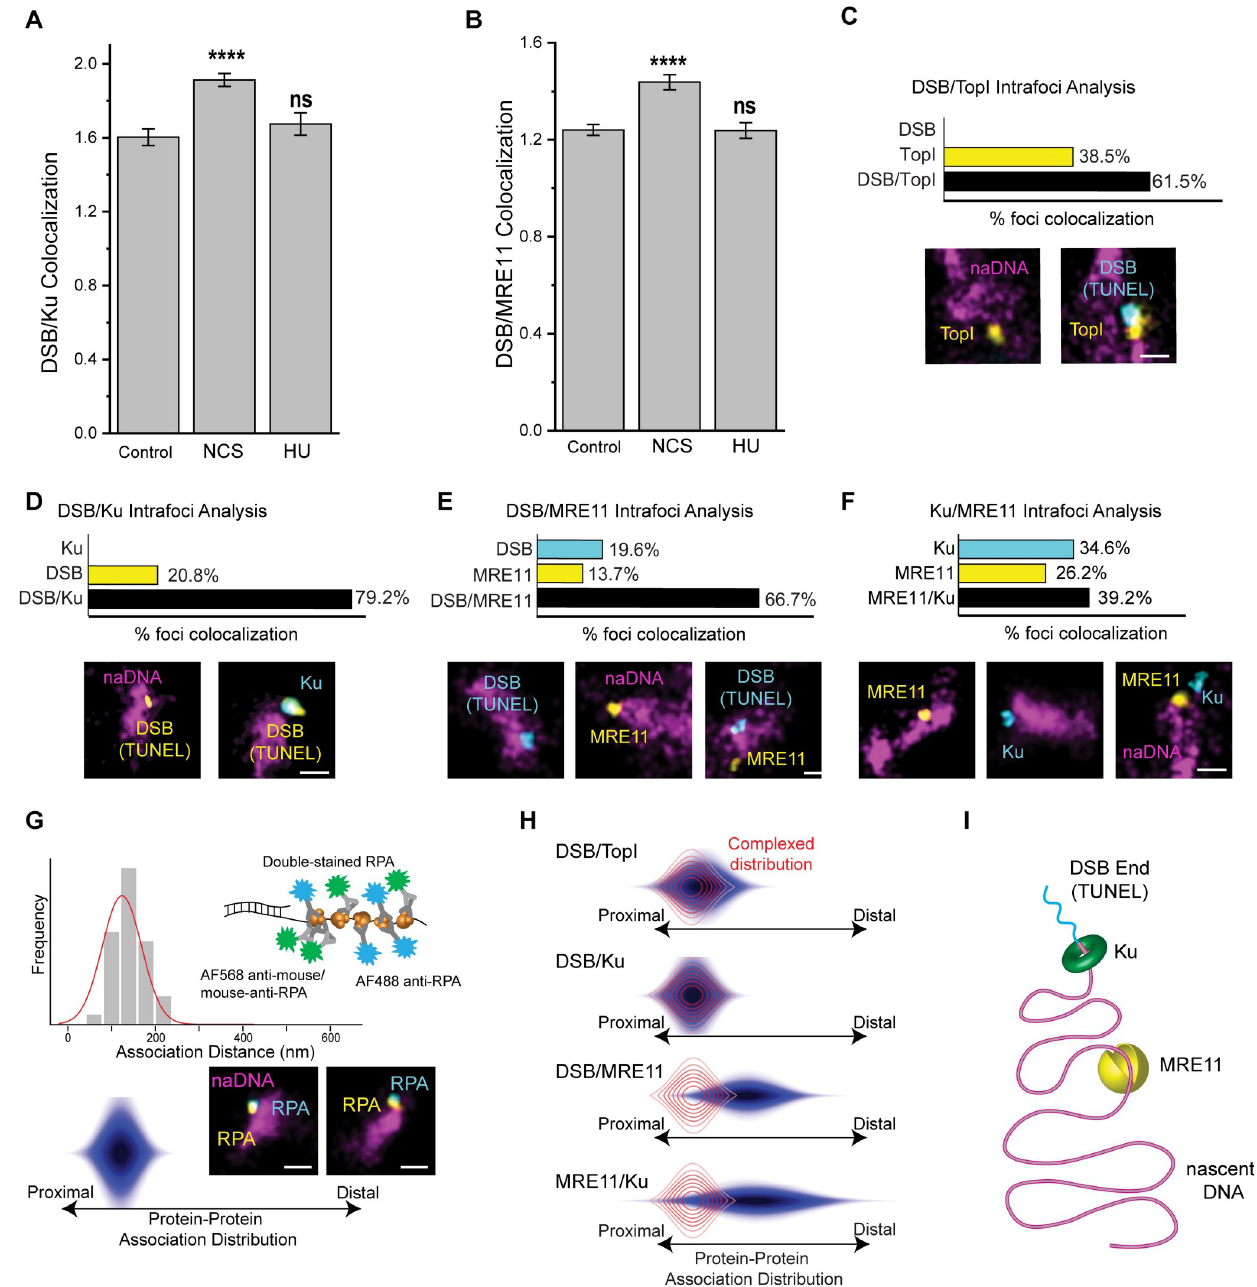
Fig 3. Ku and MRE11 colocalize to seDSB repair foci in a distally separated arrangement with Ku associating with the DSB end and MRE11 with nearby naDNA. (A) Quantification of colocalization of DSBs (via TUNEL labelling) with Ku in control cells and in cells immediately following treatment with CPT, NCS or HU. Representative whole-cell images shown in S8A–S8C Fig. (B) Quantification of colocalization of DSBs (via TUNEL labelling) with MRE11 in control cells and in cells immediately following treatment with CPT, NCS or HU. Representative whole-cell images shown in S8D–S8F Fig. (C) Three color analysis of TopI and DSB (using TUNEL labeling) localization at repair foci immediately following 1 hour of CPT damage. Representative whole-cell control and CPT-treated cells shown in S9A and S9B Fig. (D) Three color analysis of Ku and DSB (TUNEL) localization at repair foci immediately following 1 hour of CPT damage. Representative whole-cell control and CPT-treated cells shown in S9C and S9D Fig. (E) Three color analysis of MRE11 and DSB (TUNEL) localization at repair foci immediately following 1 hour of CPT damage. Representative whole-cell control and CPT-treated cells shown in S9E and S9F Fig. (F) Three color analysis of MRE11 and Ku localization at repair foci immediately following 1 hour of CPT damage. Representative whole-cell control and CPT-treated cells shown in S9G and S9H Fig. (G) A histogram (top) and resulting 3D color-contoured distribution (bottom) and accompanying model (right) showing quantification of the rendered distance between the centers of mass of the same super-resolved RPA foci immunolabeled indirectly with mouse-anti-RPA/Alexa-568-anti-mouse and directly with Alexa-488 conjugated rabbit anti-RPA. These distributions depict